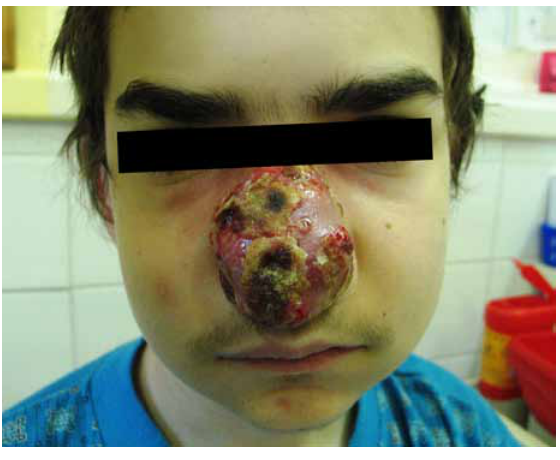
Figure 2. Facial cellulitis during antibiotic therapy and after ab- scess